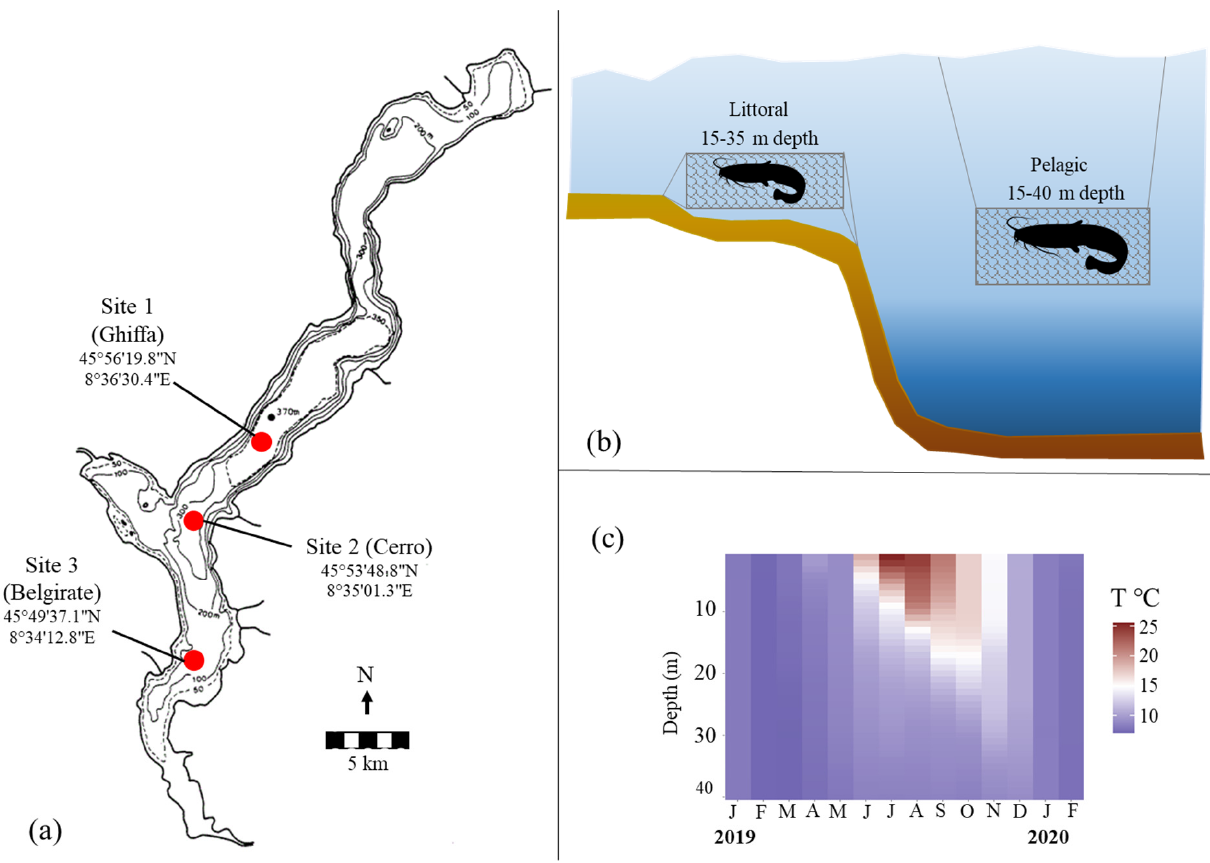
Figure 1. ( a ) Bathymetric map of Lake Maggiore (retrieved from https://wldb.ilec.or.jp/Search/listdata, (accessed on 18 August 2021)) and location of sampling sites with ( b ) schematic representation of the location of pelagic and littoral gillnets and ( c ) heatmap of temperature with depth measured for each month from January 2019 to February 2020 at the deepest point of the Lake (Ghiffa station, site 1).